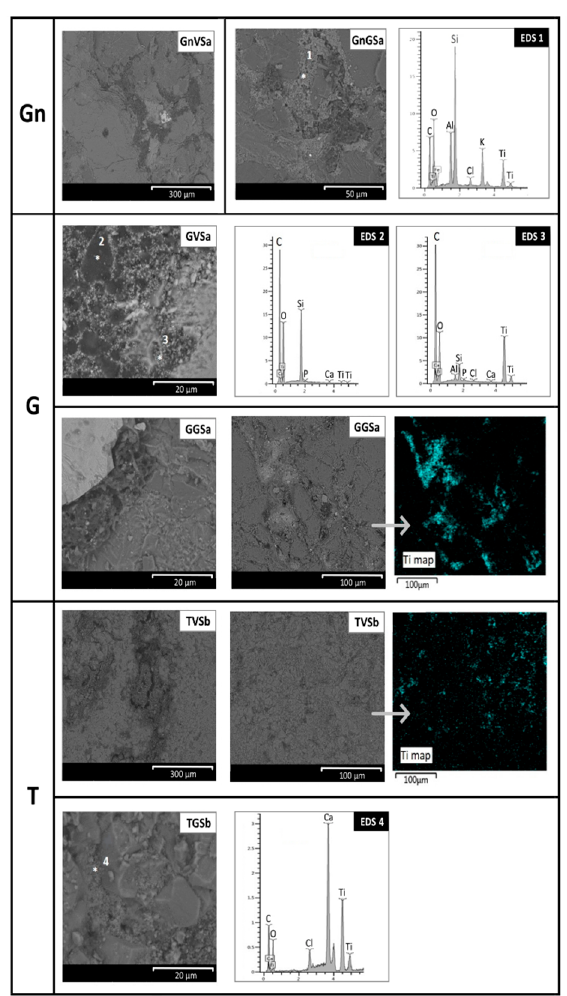
Figure 9. SEM micrographs, EDX spectra, and Ti-maps collected of the stones cleaned with the low-toxic ternary solvent mixture. Check Table 1 for sample labeling.